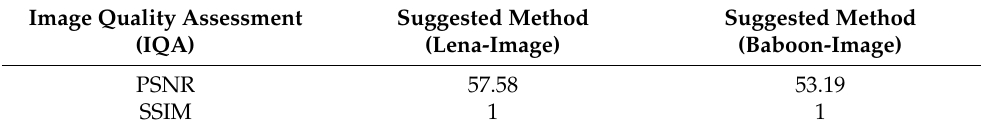
Table 3. Performance measures.